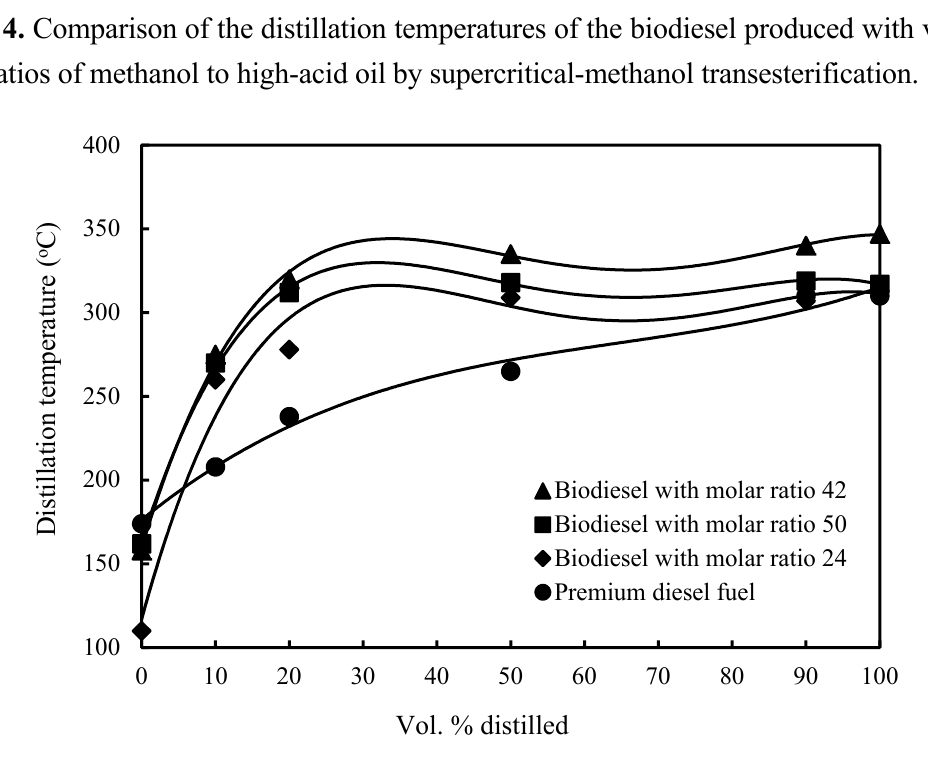
Figure 4. Comparison of the distillation temperatures of the biodiesel produced with